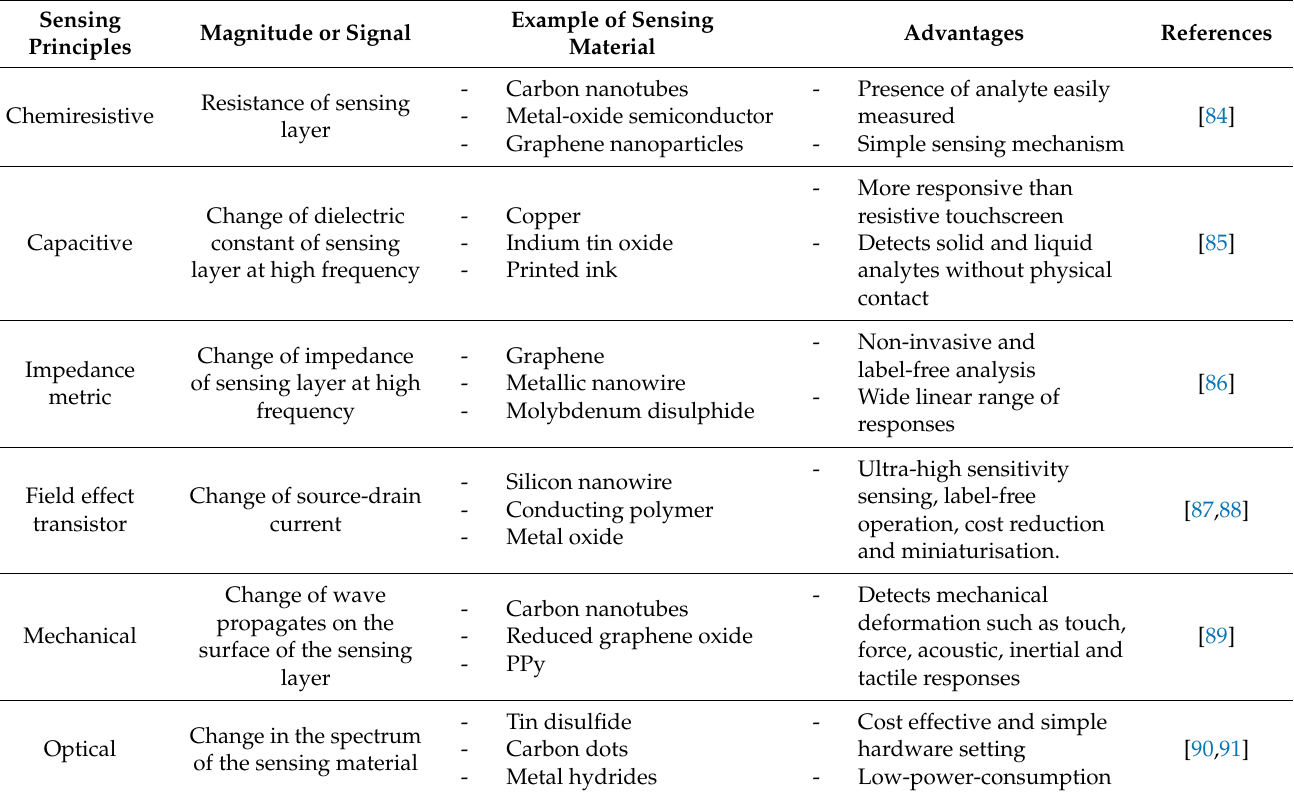
Table 2. Different types of sensing principles and signals provided by these